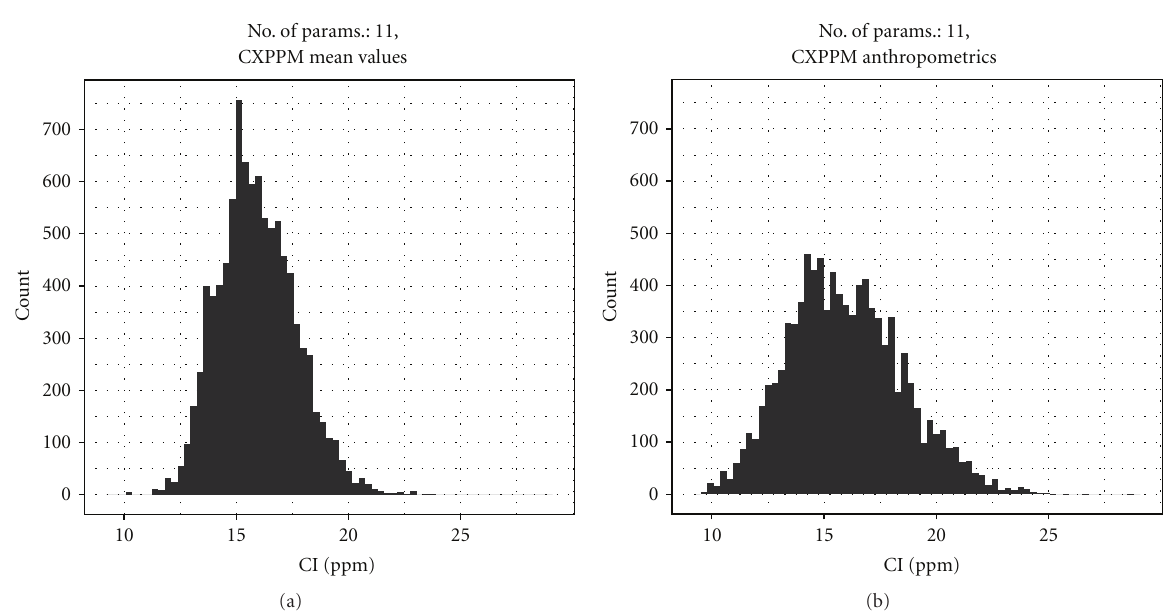
Figure 9: Comparison of estimated posterior distributions for 4-hour inhalation exposure to m -xylene. Posterior distributions were estimated by updating the most influential parameters or by fixing the measured parameters and updating the remaining most influential: (a) CXPPM, full parameter set, (b) CXPPM, most